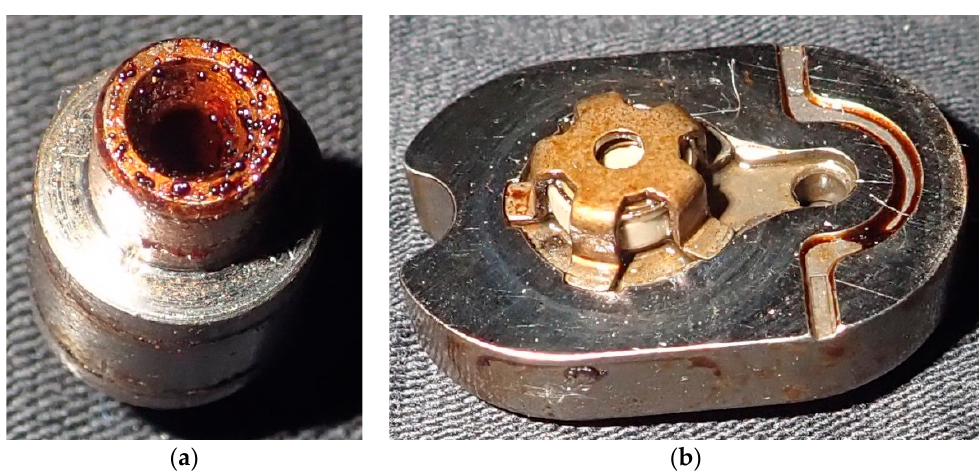
Figure 17. High-pressure delivery tube ( a ) and delivery valve ( b ) of the third cylinder, which were totally covered by sticky deposits.